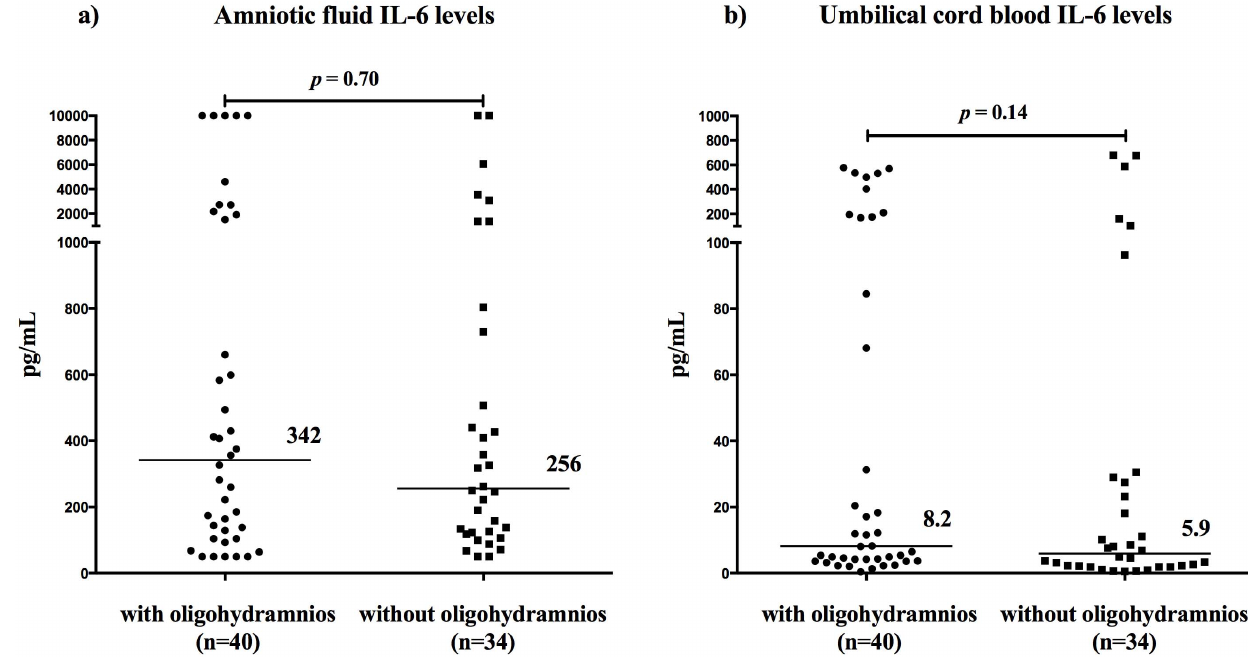
Figure 1. The amniotic fluid (a) and umbilical cord blood (b) interleukin-6 levels with respect to the presence and absence of oligohydramnios. The horizontal bars indicate the median values.